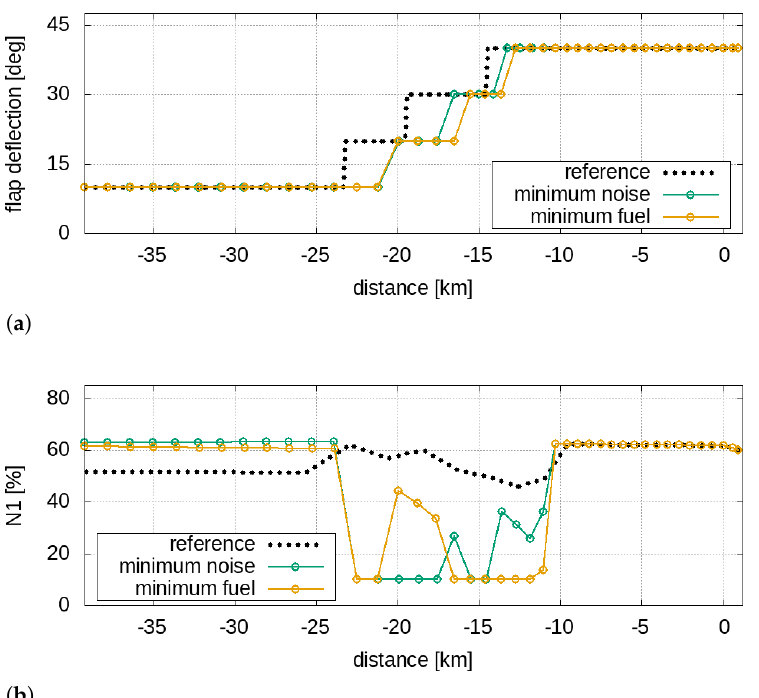
Figure 9. Approach manoeuvre for the single-aisle aircraft. Procedural variables. ( a ) flap